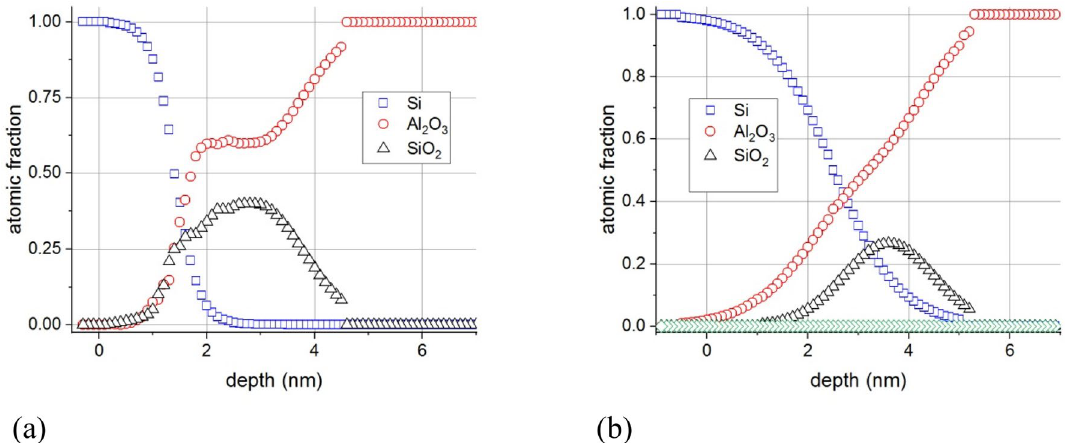
Figure 1. Concentration distributions after electron irradiation at room temperature of 5 keV, I = 500 nA, 21 h for samples ( a ) 5 nm Al 2 O 3 /Si and ( b ) 20 nm Al 2 O 3 /Si (the non-altered part of the sample is not shown). The position of the original Al 2 O 3 /Si interface is at 0 nm, the positive direction is toward the layer. The denotations Si, Al 2 O 3 , and SiO 2 in the legend stand for pure Al 2 O 3 , (metallic) Si, and SiO 2 ,